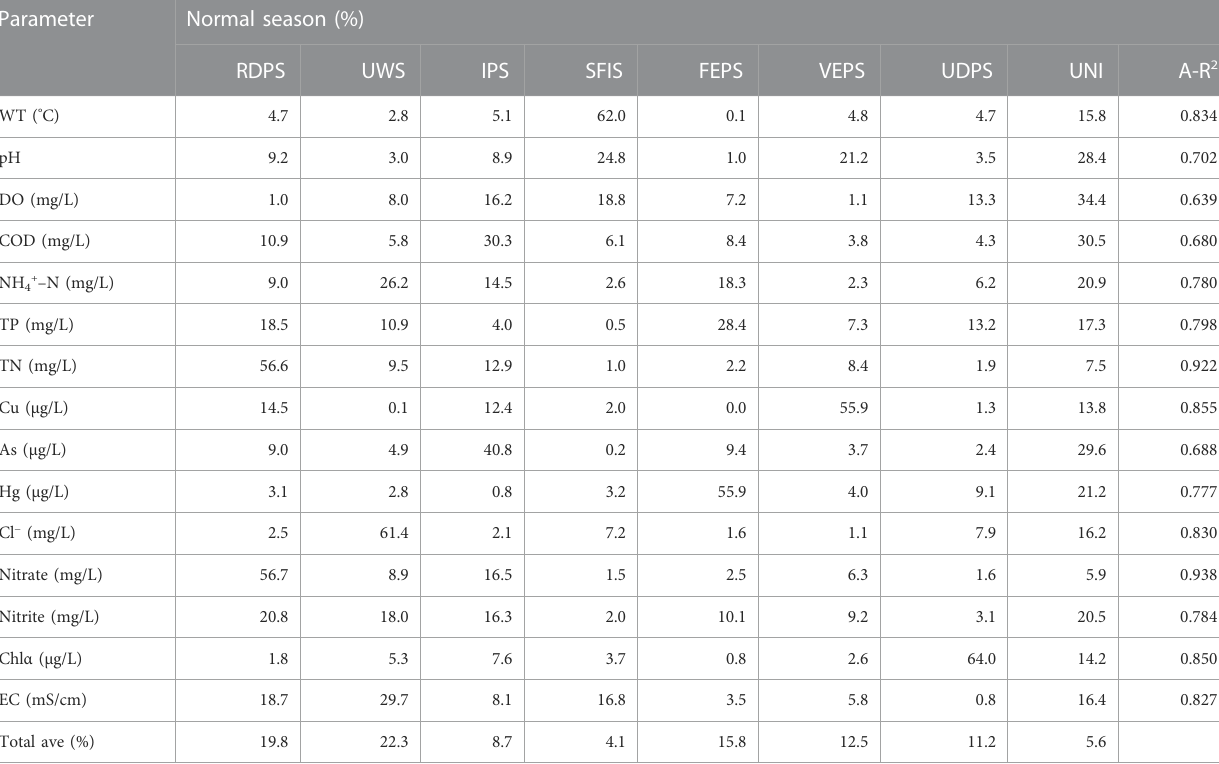
TABLE 4 Contribution of pollution sources for each pollutant in the normal season with PCA/FA results.